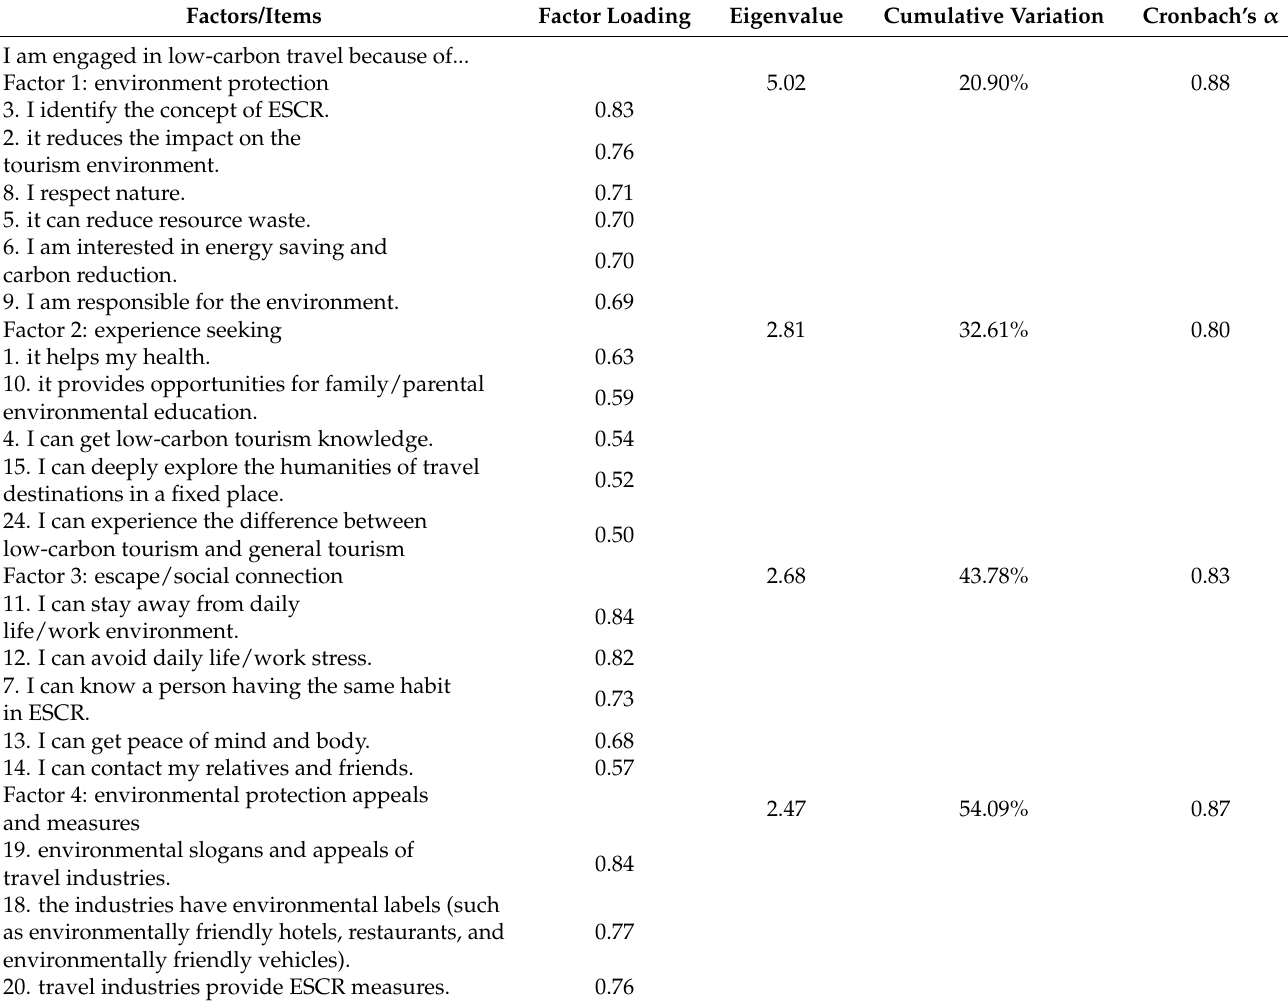
Table 2. EFA results of LCTMS—sample from low-carbon destination ( n = 382). Factor Loading Eigenvalue Cumulative